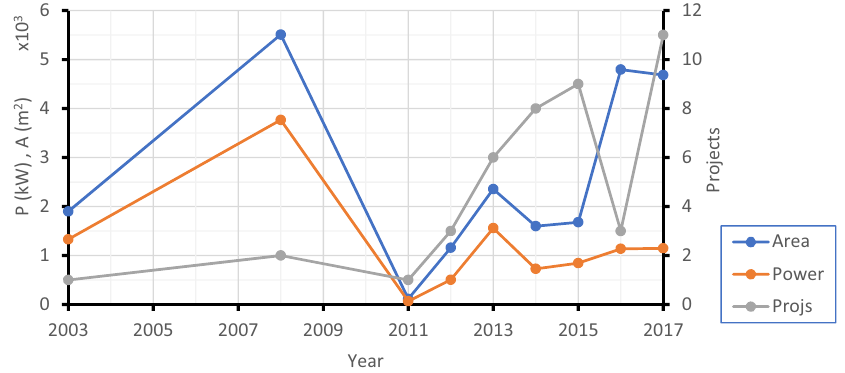
Figure 22: Technical every - year evolution of SHIP